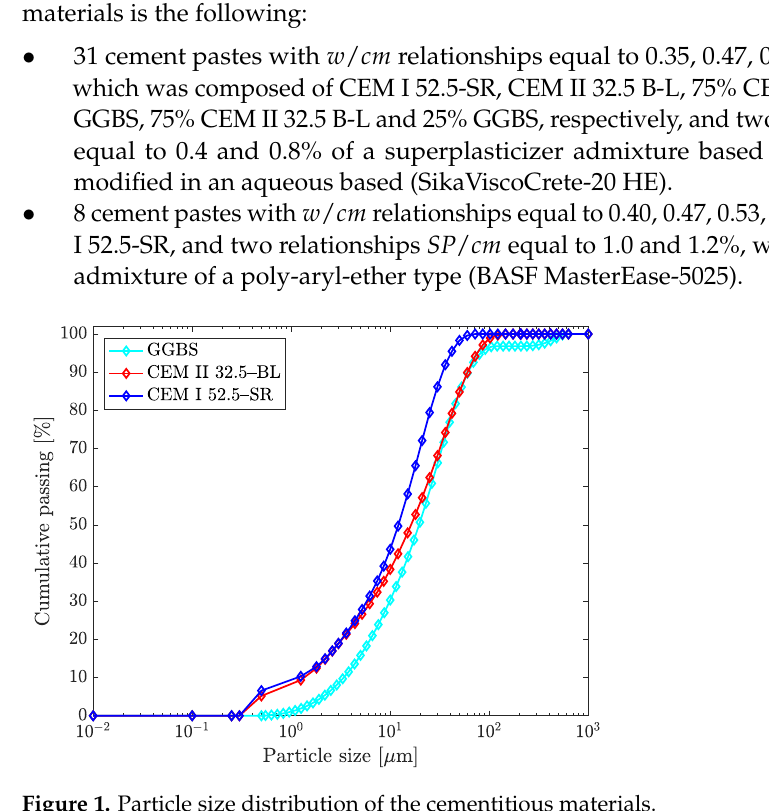
Figure 1. Particle size distribution of the cementitious